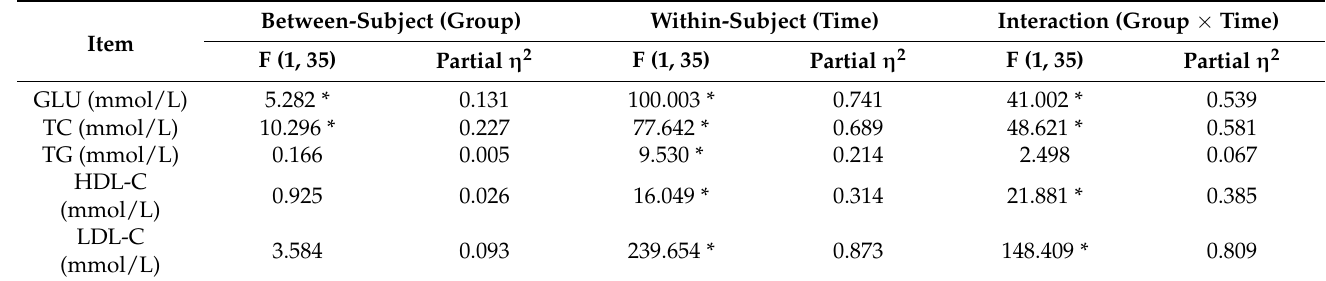
Table 4. The influence of different interventions on serum biomarkers (two-way ANOVA).